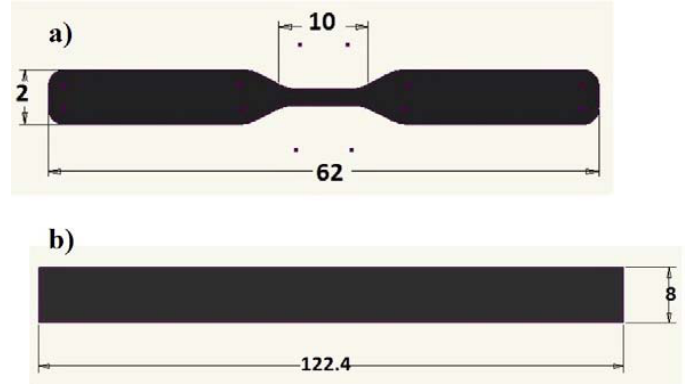
Figure 2. Standard specimen ( a ) Tension test; ( b ) Impact test. (Unit: mm)